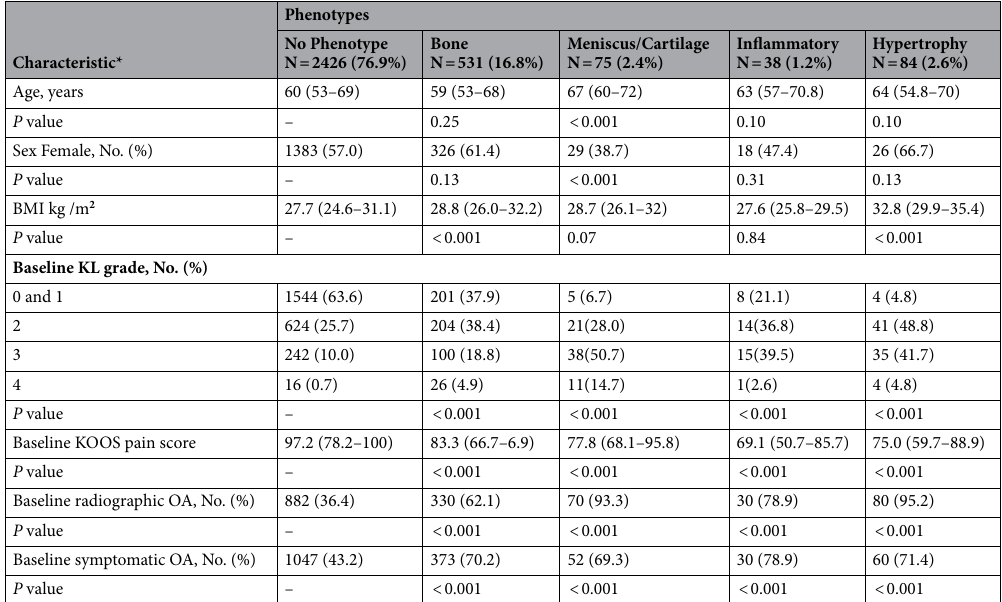
Table 1. Baseline characteristics for the analytic sample by phenotype group. *Median (interquartile range) or percentage. -: not applicable, BMI: body mass index, KL: Kellgren-Lawrence, KOOS: Knee Injury and Osteoarthritis Outcome